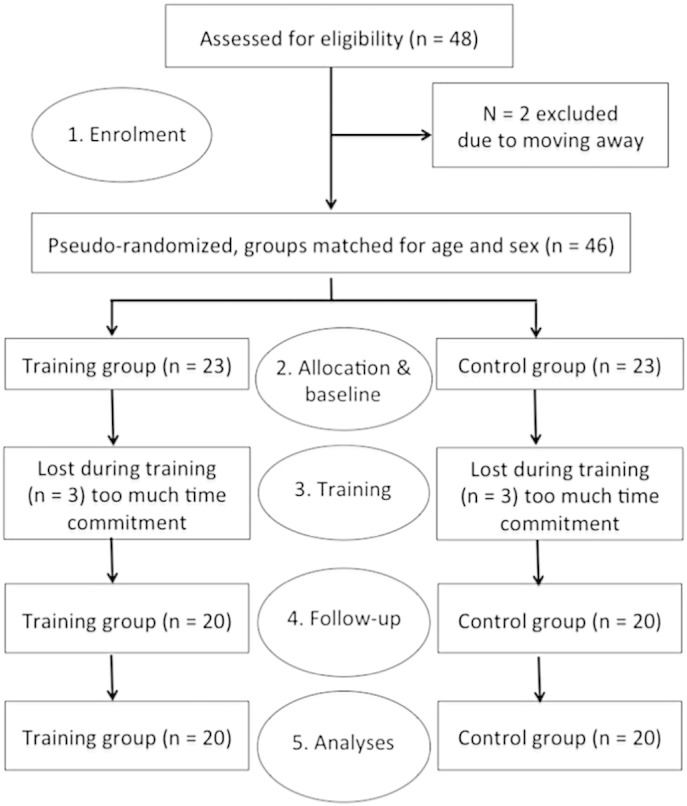
Flow diagram following the CONSORT guidelines (http://www.consort-statement.org/consort-statement/flow-diagram) of participants' progress through the different study stages of enrolment, training allocation, baseline MRI and cognitive assessment, working memory training phase, follow-up MRI and cognitive assessment and data analyses.